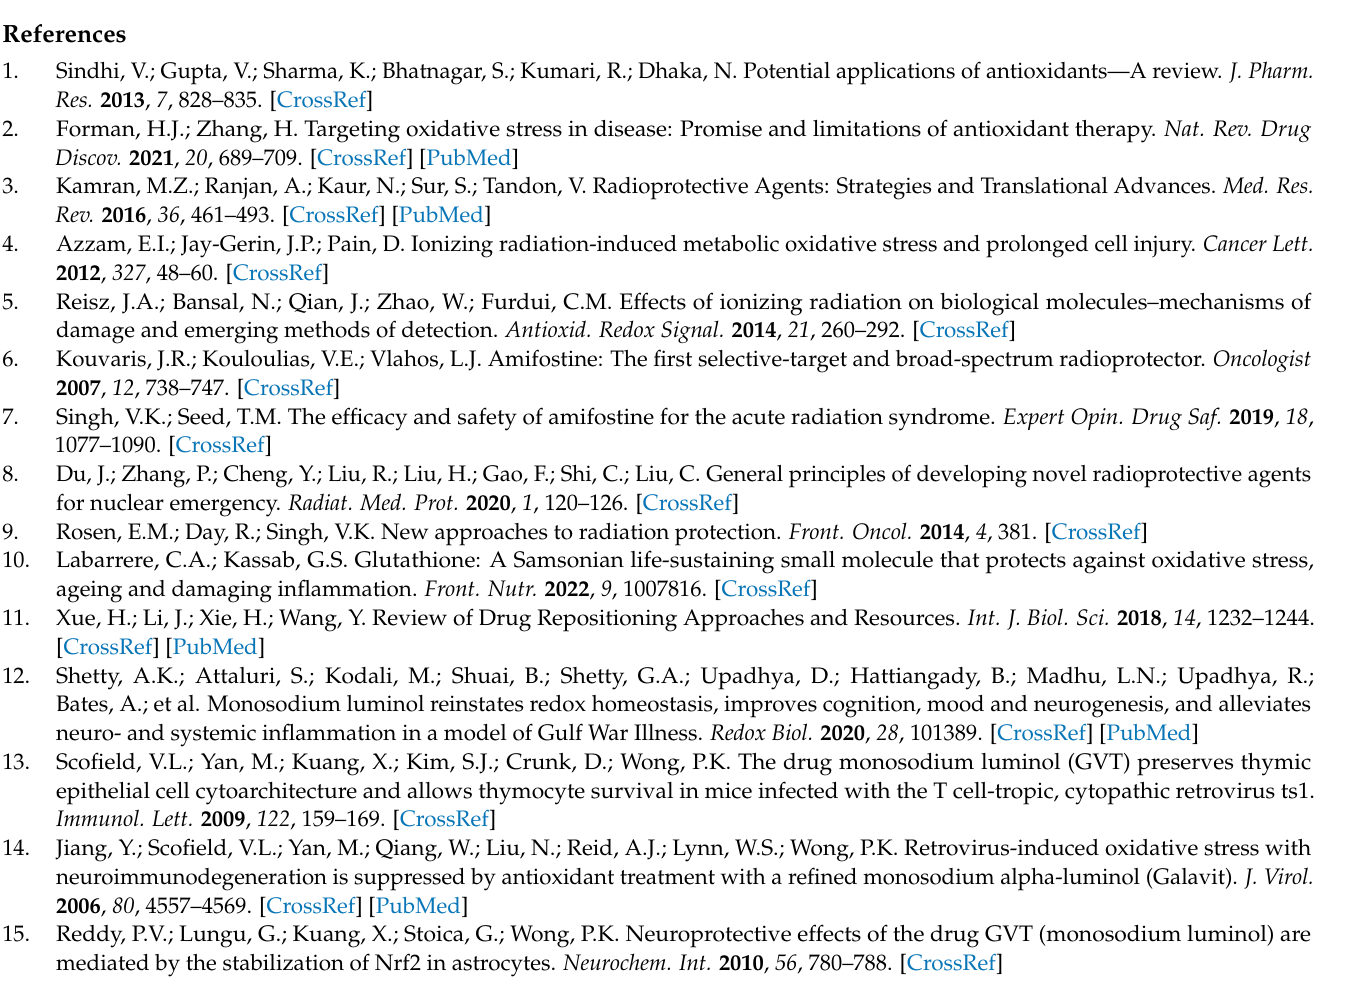
Figure S2: Structural chemical formula of Tameron (5-amino-2,3-dihydro-1,4-phthalazinedione sodium salt); Figure S3: Mitotic cells in planarian bodies (whole-mount Immunocytochemistry) 7 days after 15 Gy irradiation; Table S1: Selected gene groups for RT-PCR analysis of neoblast marker genes. Table S2: Selected gene groups for RT-PCR analysis of oxidative stress response